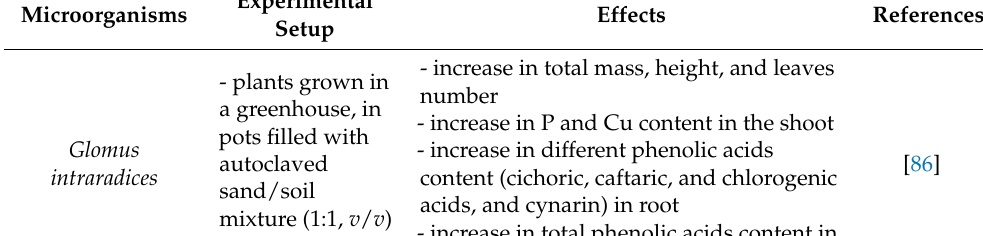
Table 1. Echinacea purpurea cultivation with mutualistic microorganisms.